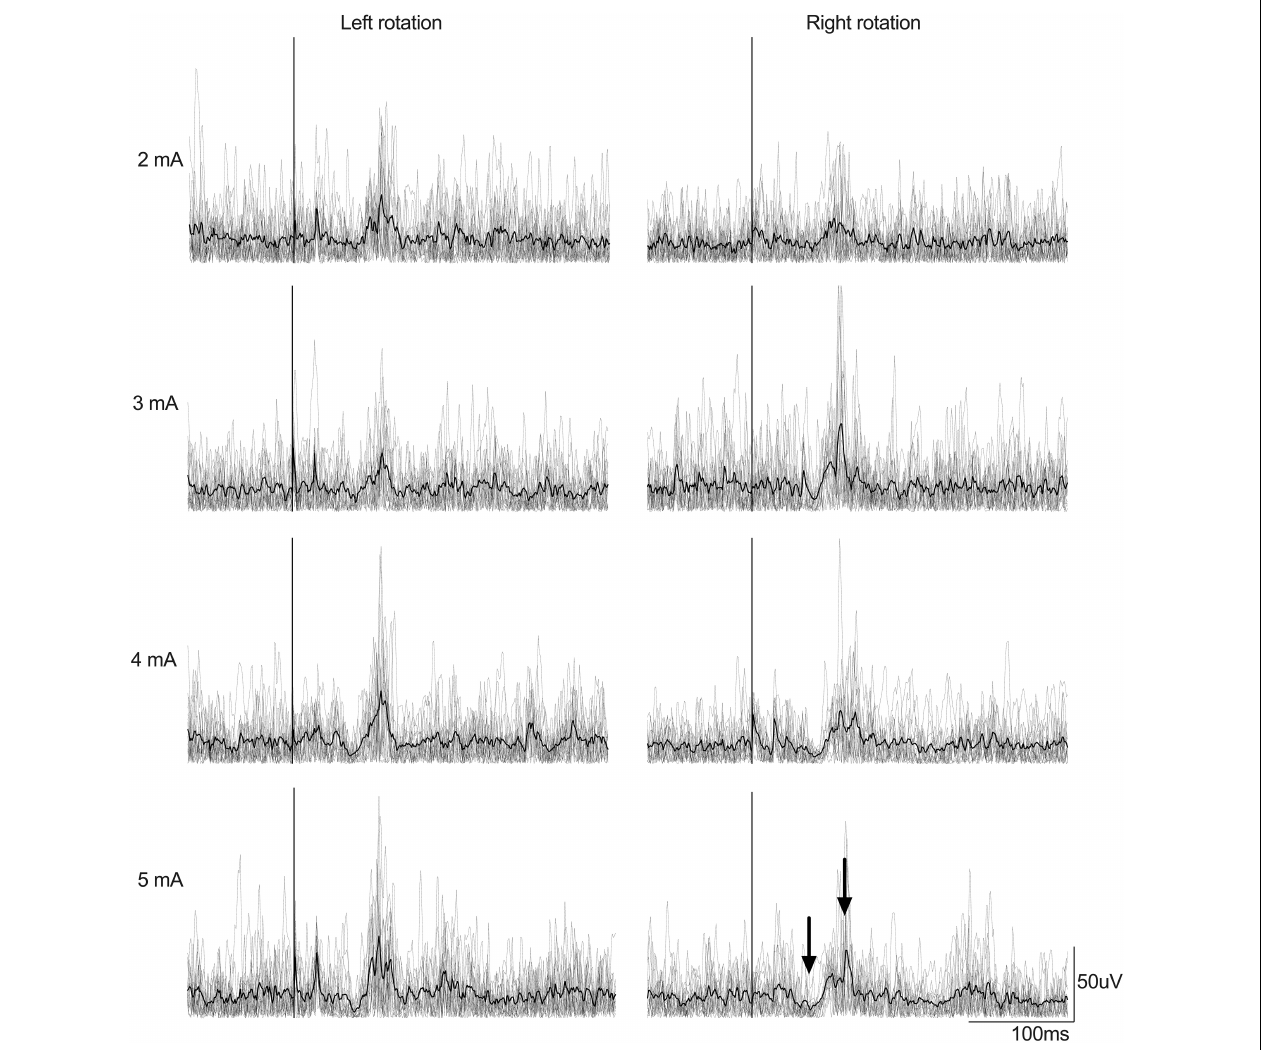
FIGURE 2 | Example of rectified EMG signals recorded from the right LES muscles from a participant according to EVS intensity (EVS duration was 20 ms). Left column depicts muscle amplitude for left head rotation and right column show muscle amplitude for right head rotation. Gray lines represent the EMG traces recorded for each 15 stimulations by condition whereas the black line represents the average EMG signal by condition. The stimulation is set at Time 0 (the vertical line). Arrows, respectively, show the short- and medium-latency